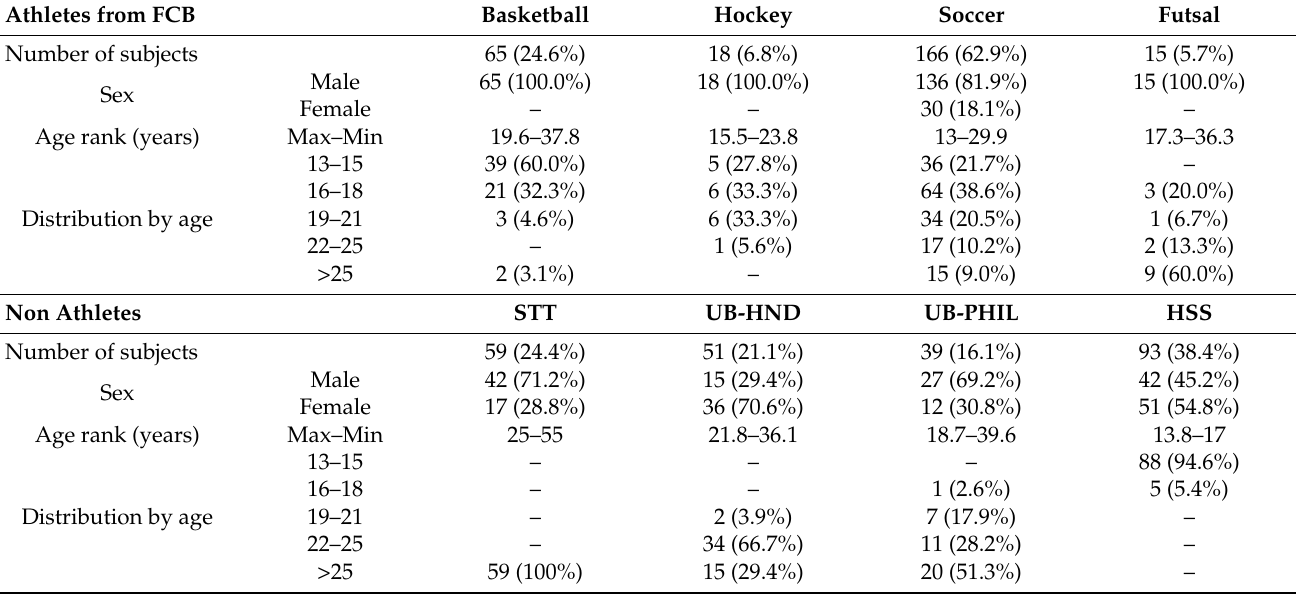
Table 1. Sex and age distribution in athletes ( n = 264) and non-athletes’ ( n = 242) groups. Abbre- viations: FCB, athletes of Fútbol Club Barcelona; HSS, high-school students; UB-PHIL,